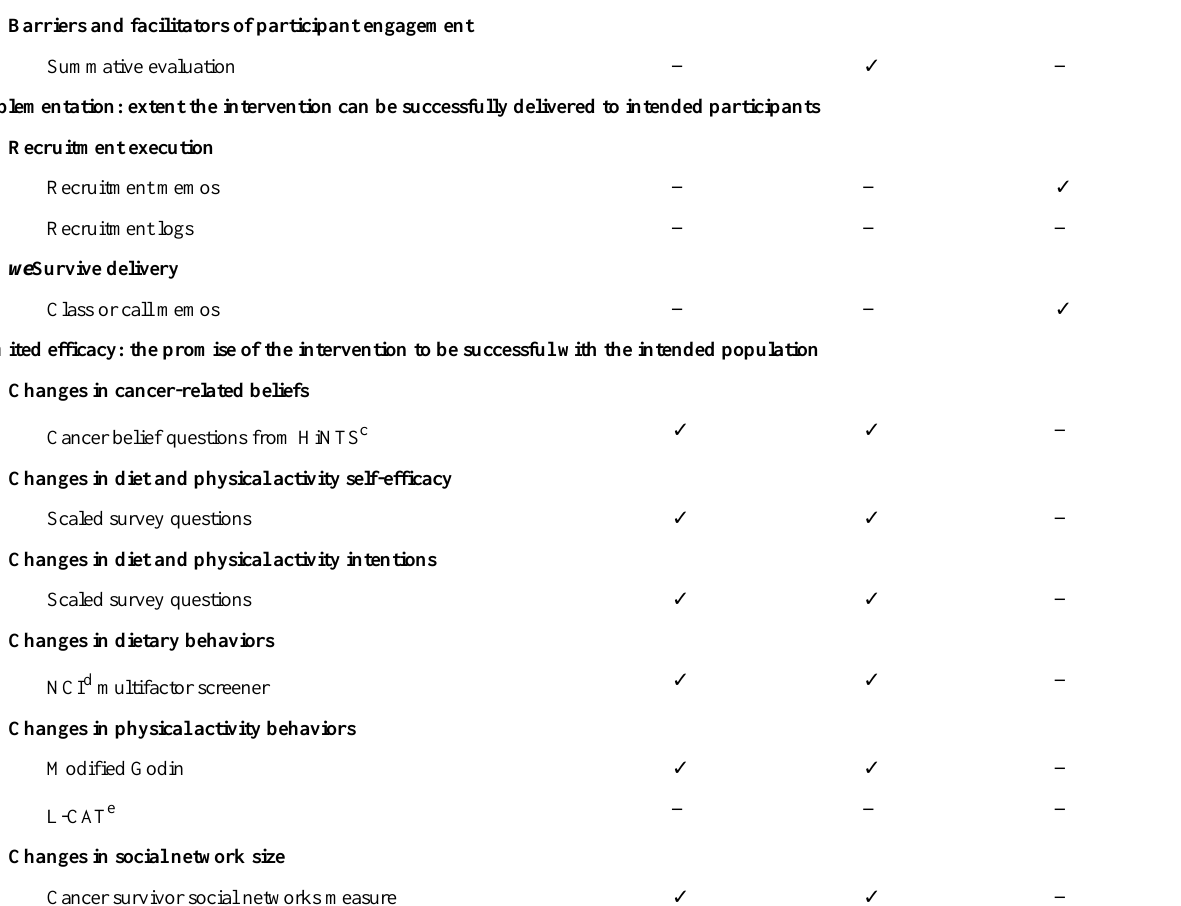
and without outside